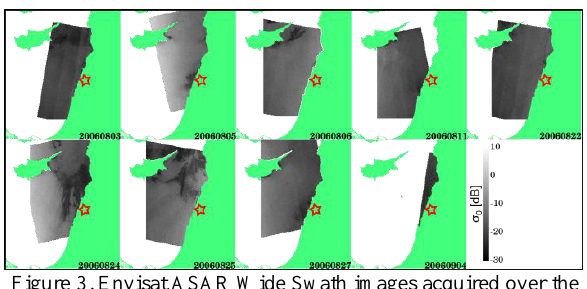
Figure 3. Envisat ASAR Wide Swath images acquired over the study area during the oil spill. Land areas are masked with light green color. The red star denotes the approximate location of the Jiyeh Power